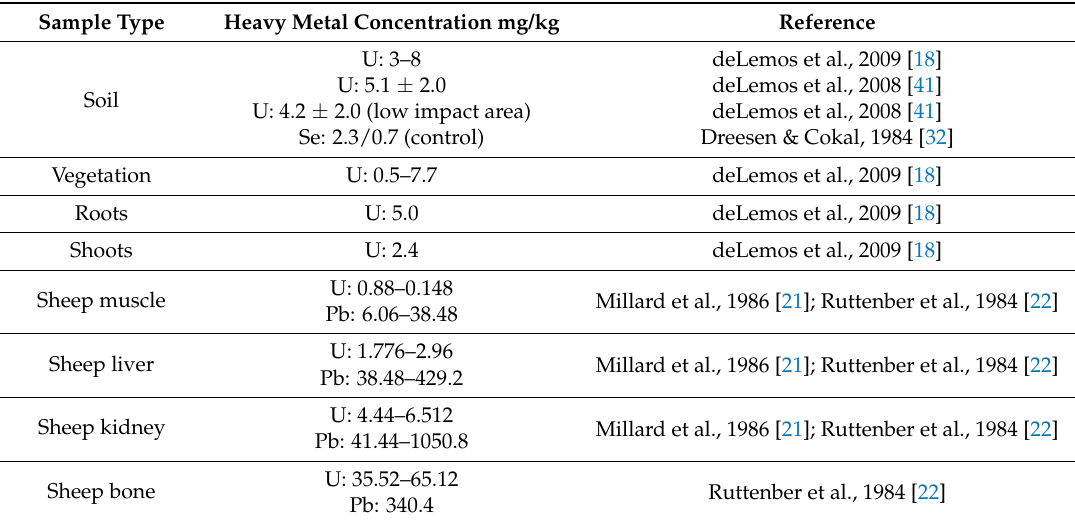
Table 6. Heavy metal concentrations in soil, plants, and sheep tissue from previous studies in the study area. Heavy metal concentrations are reported for high impact areas unless otherwise